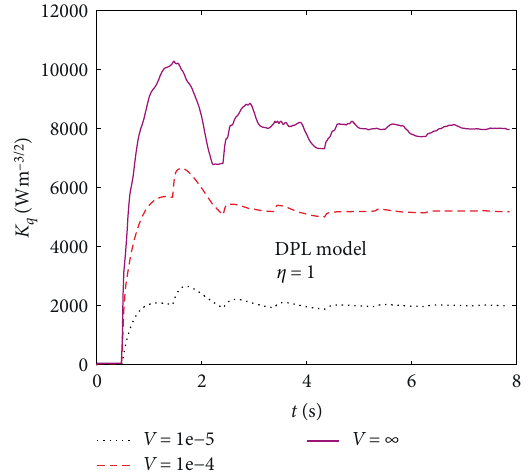
Figure 11: Effect of thermal resistance of crack on HFIF of nonhomogeneous cylinder with